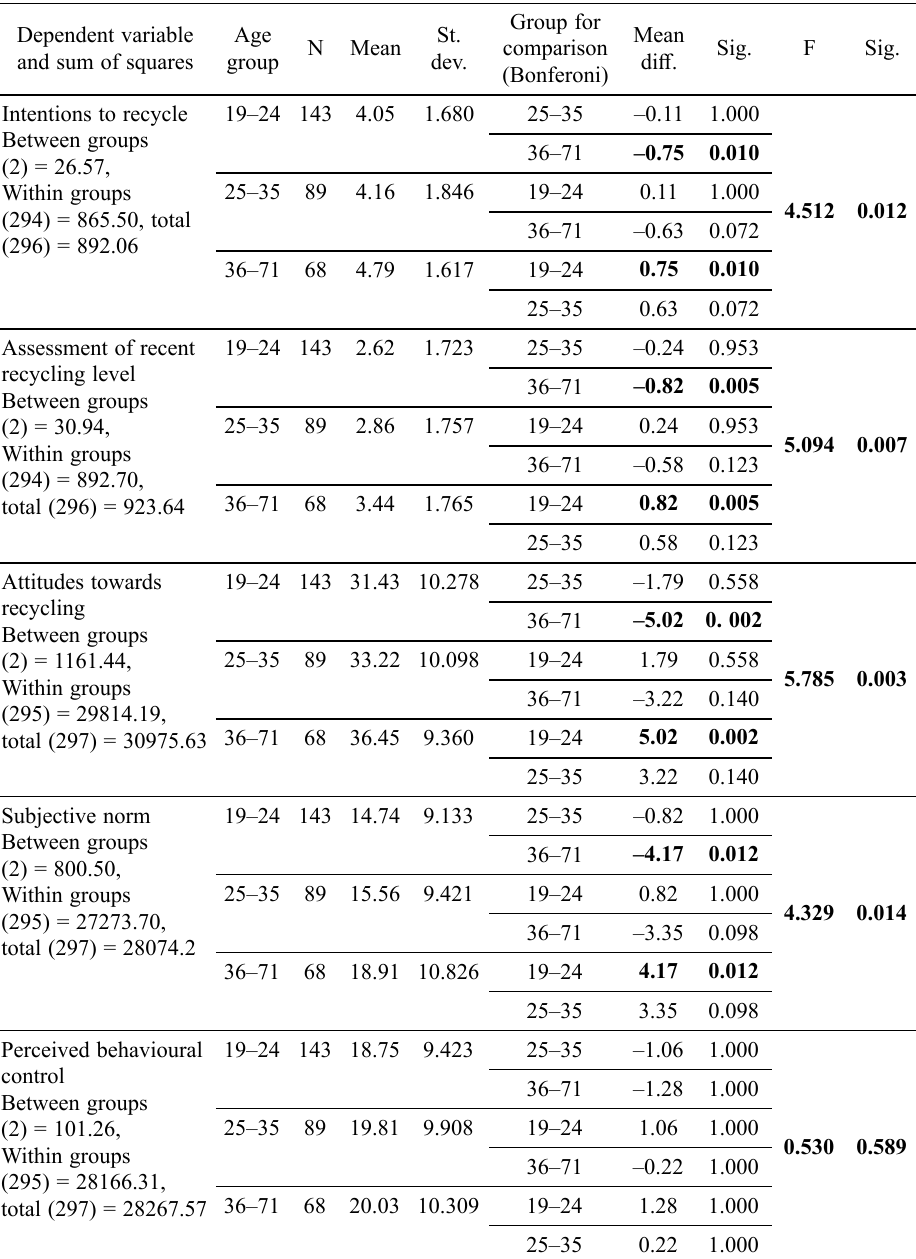
Table 6. Differences in intentions to recycle, recent recycling behaviour, attitude